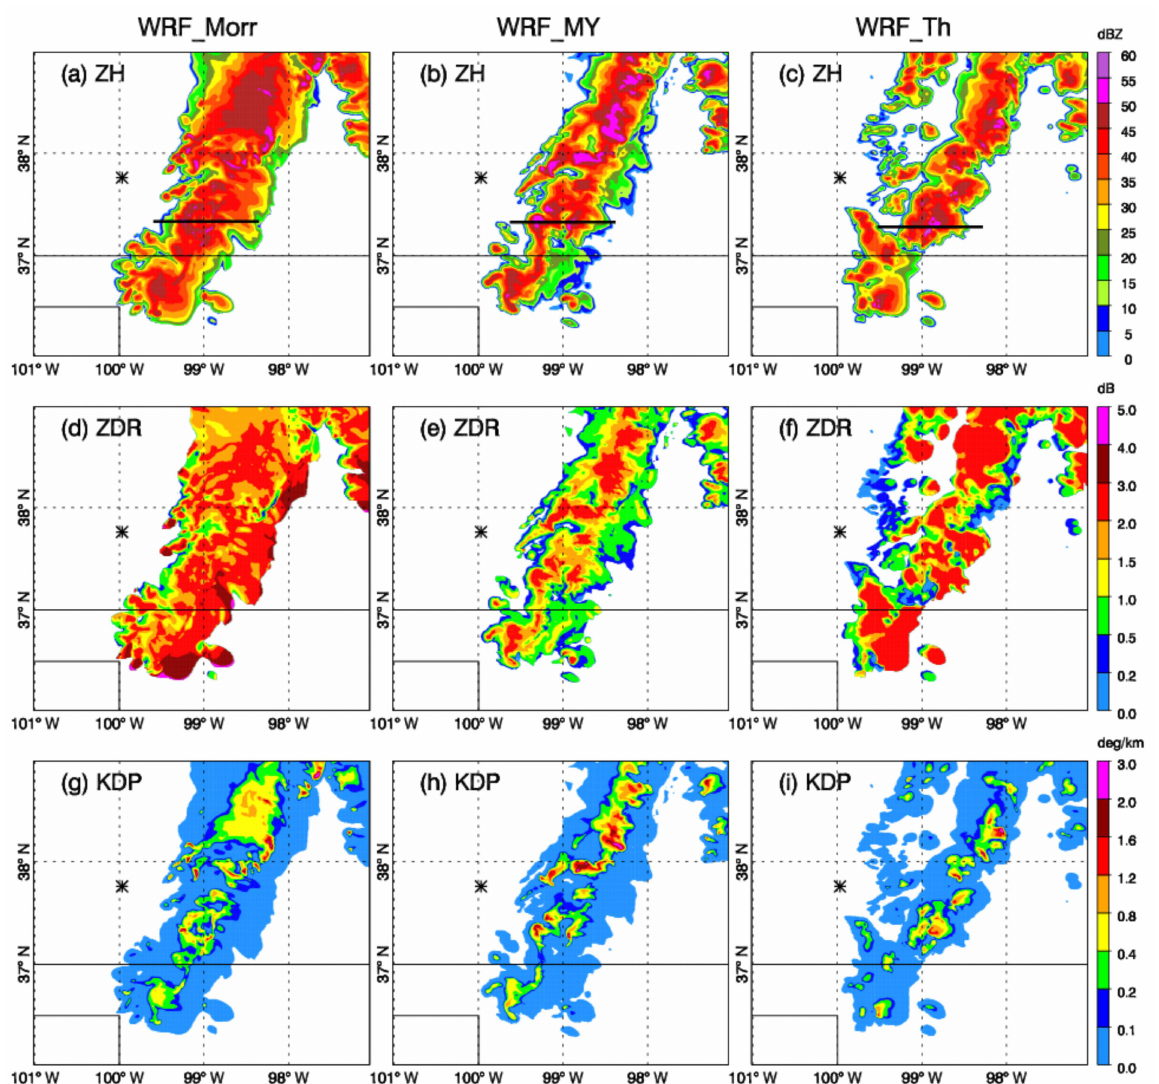
Figure 5. Z H ( a – c ), Z DR ( d – f ), and K DP ( g – i ) for WRF_Morr, WRF_MY, and WRF_Th, respectively. All plots are for the fields at 2345 UTC 29 May 2018 at 1 km height. The black star shows the location of the KDDC radar. The black lines show the location of the cross-section discussed in Section 3.3.